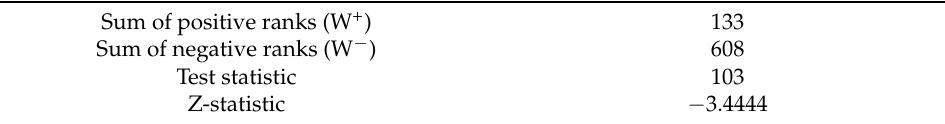
Table 2. Results of the Wilcoxon signed-rank